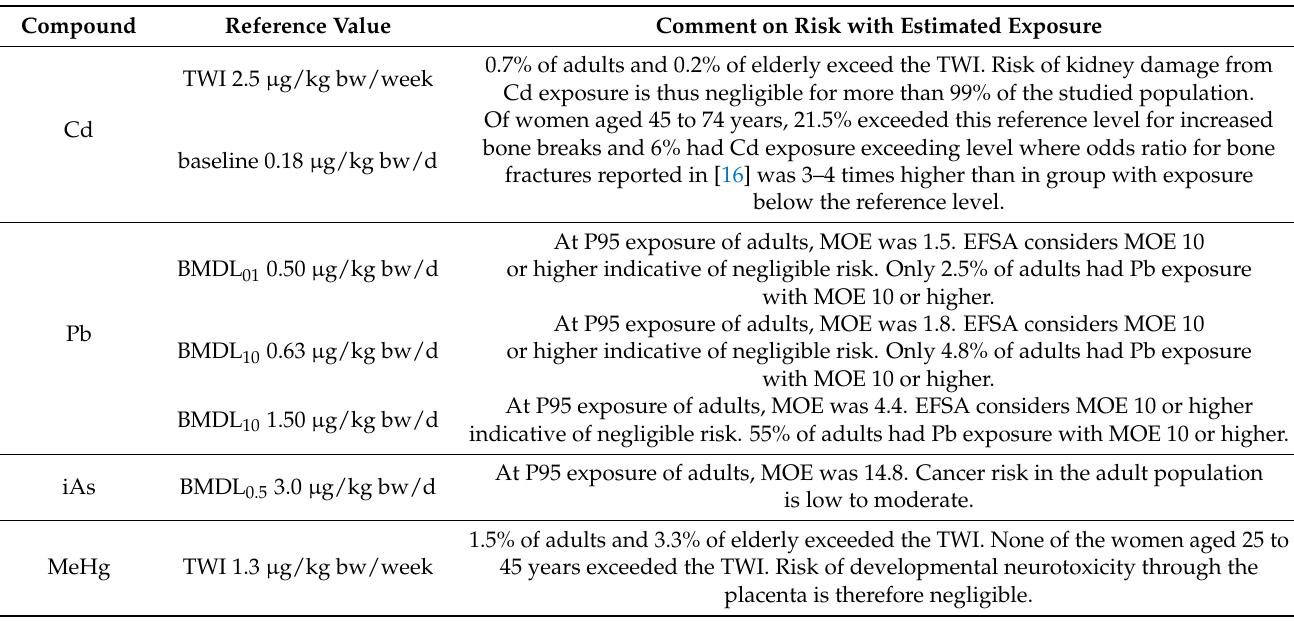
Table 4. Risk from dietary exposure of adult (25 to 64 years) and elderly (65 to 74 years) Finns, assessed with the FinDiet 2012 survey data on food consumption. MOE is margin of exposure, determined as health-based guidance value divided by exposure. TWI and TDI are tolerable weekly intake and tolerable daily intake, respectively; BMDL is the lower limit of benchmark dose and the subscript shows the % of change from the baseline. Of the compounds, MeHg is methyl mercury, iHg inorganic mercury and iAs inorganic